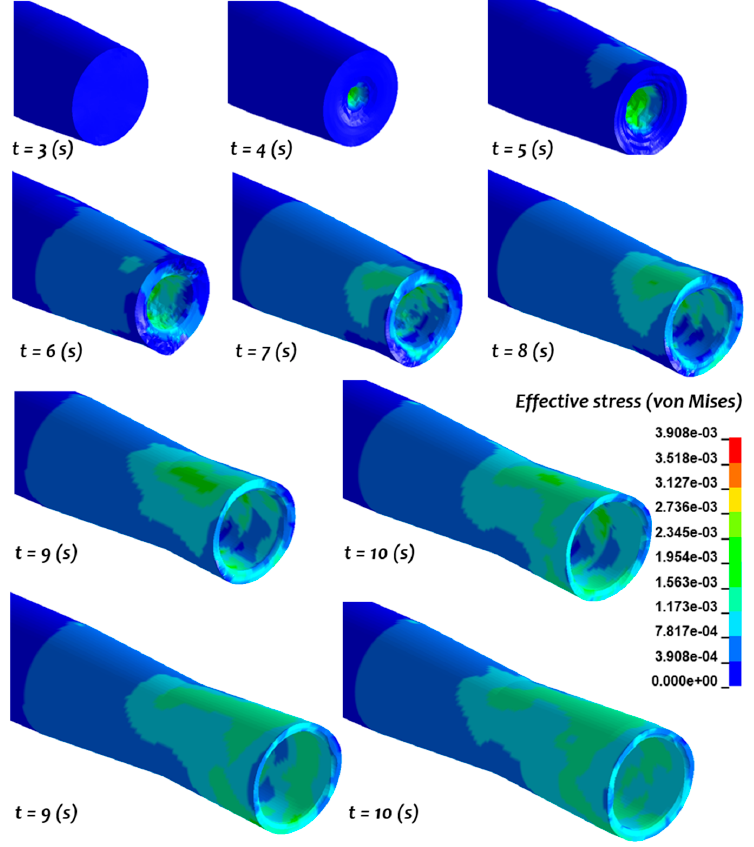
Figure 9. Contour plots of pressure showing the development of the pipe geometry.